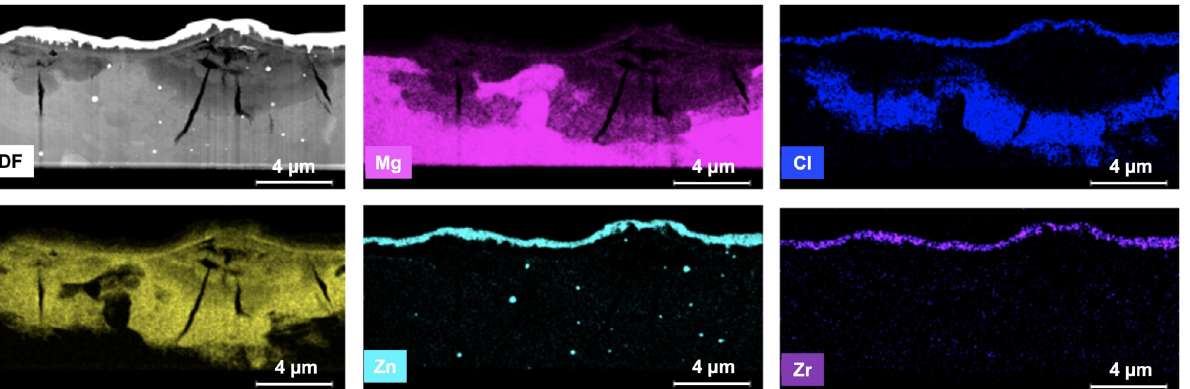
corrosion product.